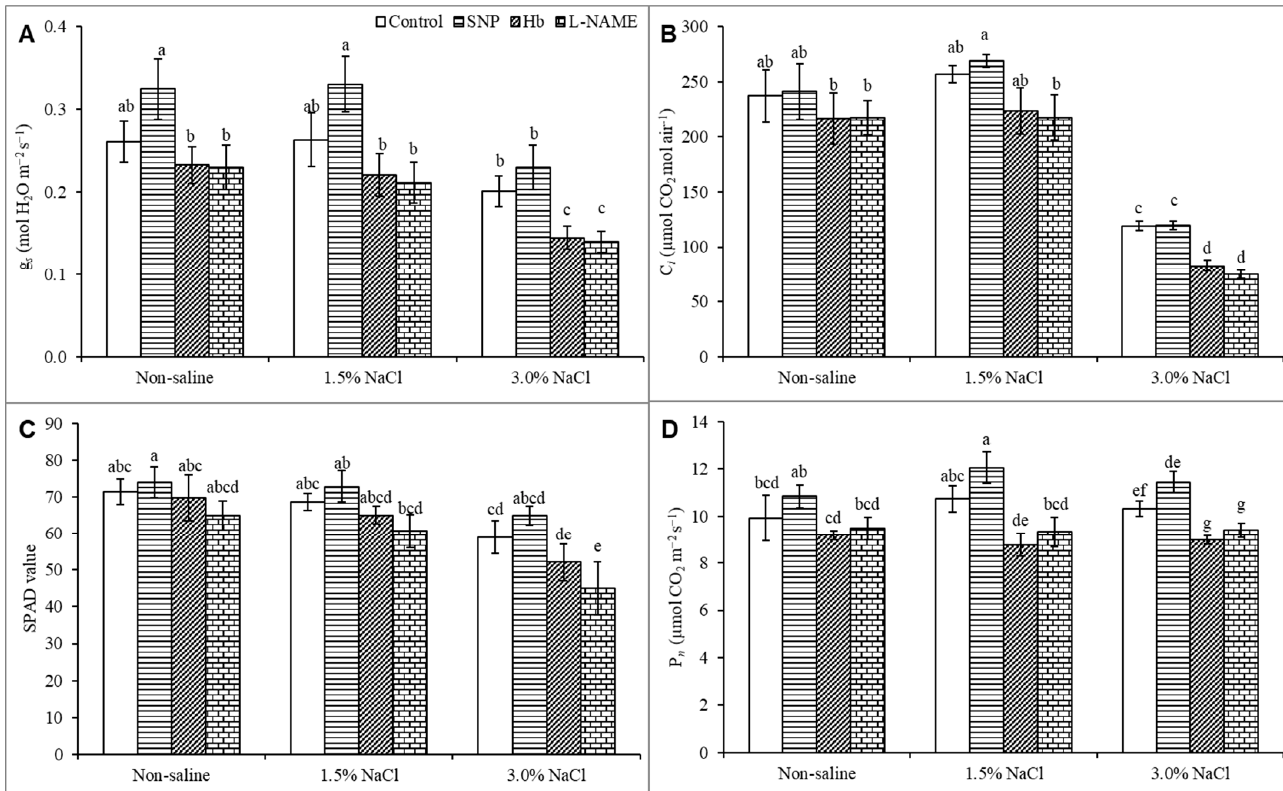
Figure 3. Stomatal conductance, g s ( A ); internal [CO 2 ], C i ( B ); SPAD value ( C ) and net photosynthesis, P n ( D ) of Kandelia obovata treated with different salt concentrations and with 100 µM sodium nitroprusside (SNP, a NO donor), hemoglobin (Hb, a NO scavenger), or N ω -nitro- L -arginine methyl ester ( L -NAME, a NO synthase inhibitor). Mean (± SD) was calculated from three replicates for each treatment. Bars with different letters are significantly different at p ≤ 0.05, applying Tukey’s HSD test.